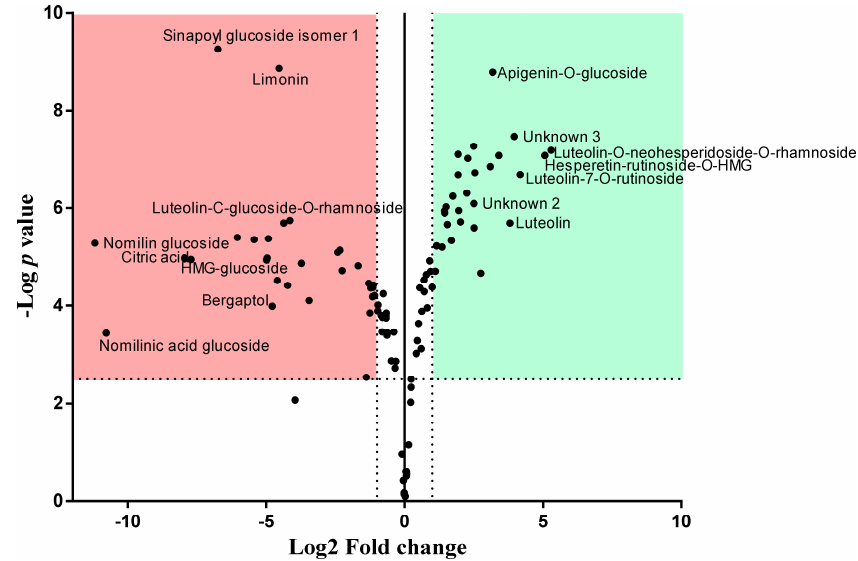
Figure 4. Volcano plot showing the semi-quantitative difference for each metabolite present in the two extracts. Those compounds significantly higher in BFPF are in red, while those significantly higher in BLPF are in green. The most statistically different compounds are named.